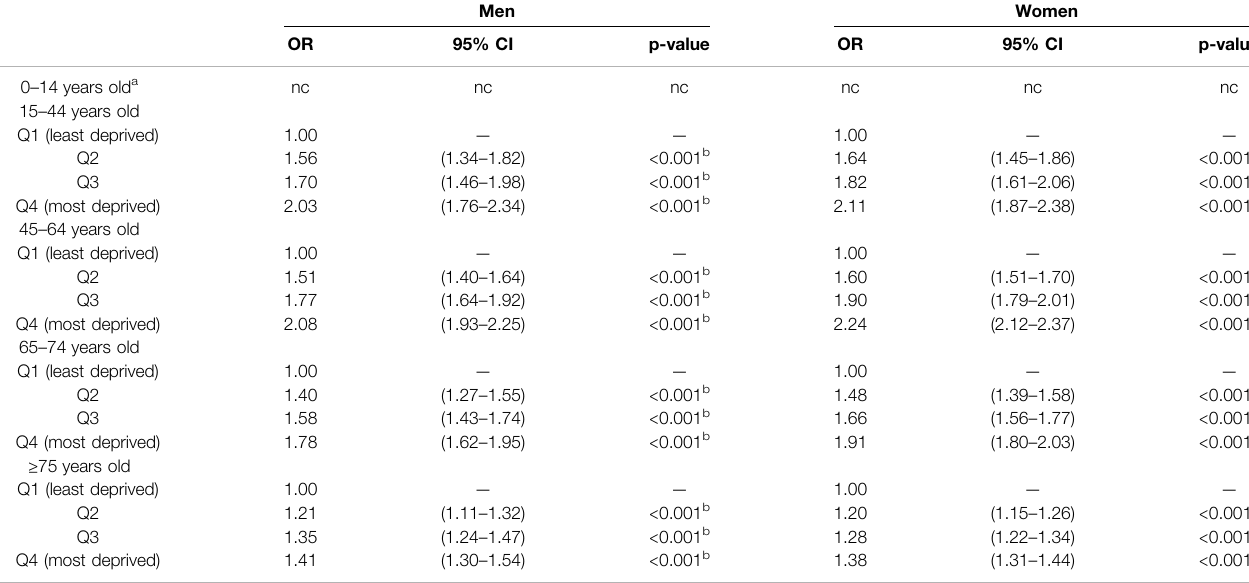
TABLE 3 | Odds ratio (OR) of weak opioids use by sex, age and composite socioeconomic index (quartiles) adjusted for cancer diagnosis and age in Catalonia, 2019.